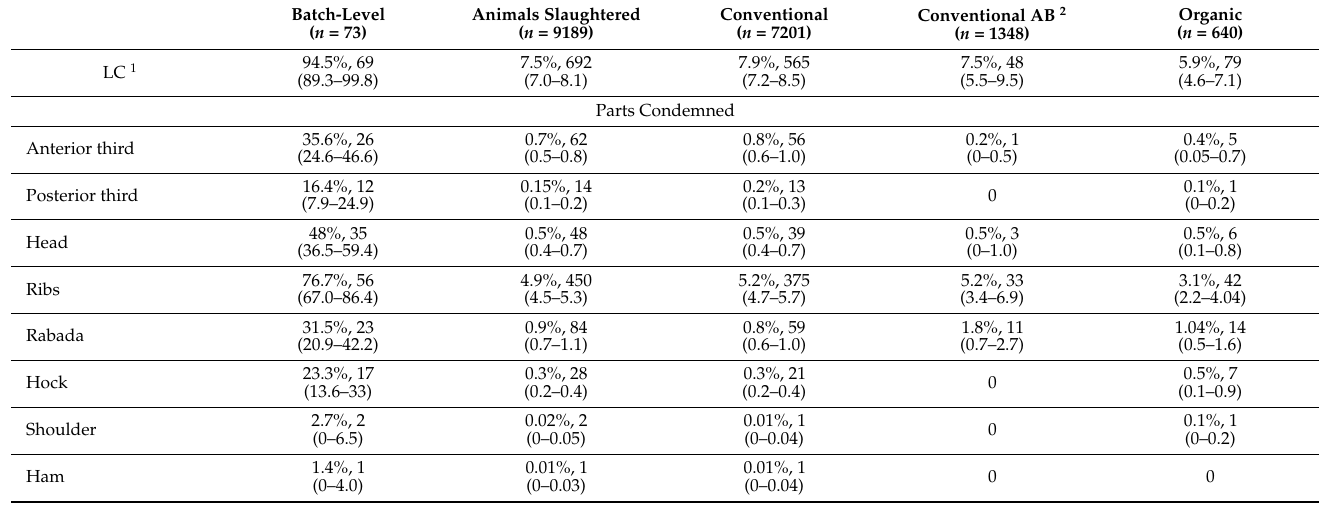
Table 4. Batch-level (% of batches with at least one condemnation/no. of examined batches) and all population-level (% of pigs/no. of examined pigs) prevalence of local condemnations and its distribution over the various production types. Unless otherwise specified, 95% confidence intervals (CI) of the prevalence are reported within